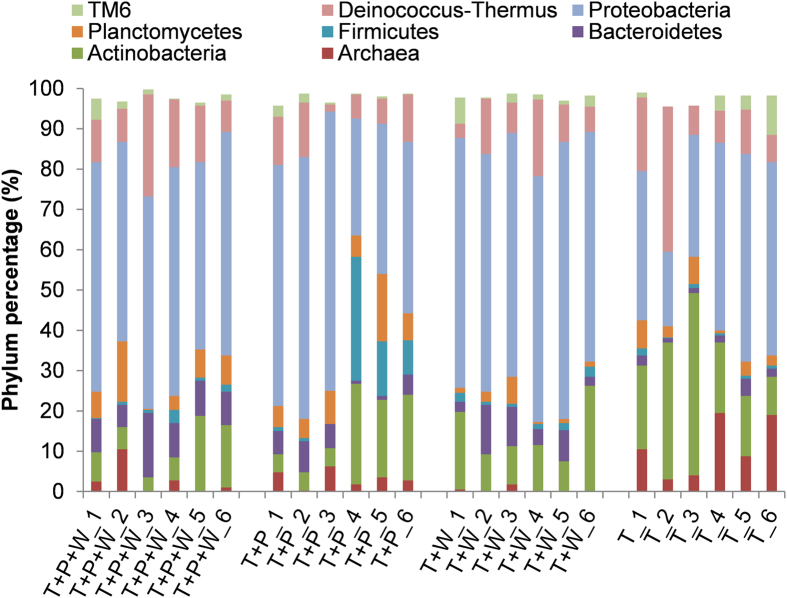
Phylum-level microbial composition of the tailings samples in this study.The phyla with a low frequency (<3%) in all the samples, including Acidobacteria, Armatimonadetes, Chlamydiae, Cyanobacteria, TM7, SBR1093, OP11 and Chloroflexi, were not shown in this figure.